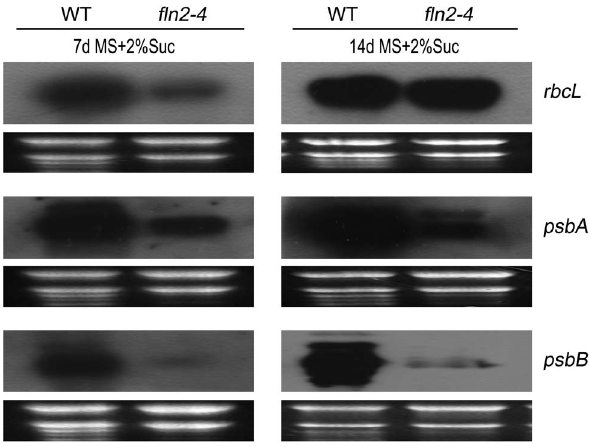
Figure 6. Changes in the transcript levels of PEP-dependent genes during the greening process of fln2–4 mutant. The expression levels of rbcL , psbA and psbB genes in 7-day-old and 14- day-old fln2–4 mutants were determined by Northern blot as compared with WT, respectively. The experimental WT and fln2–4 seedlings were grown on sucrose-containing MS